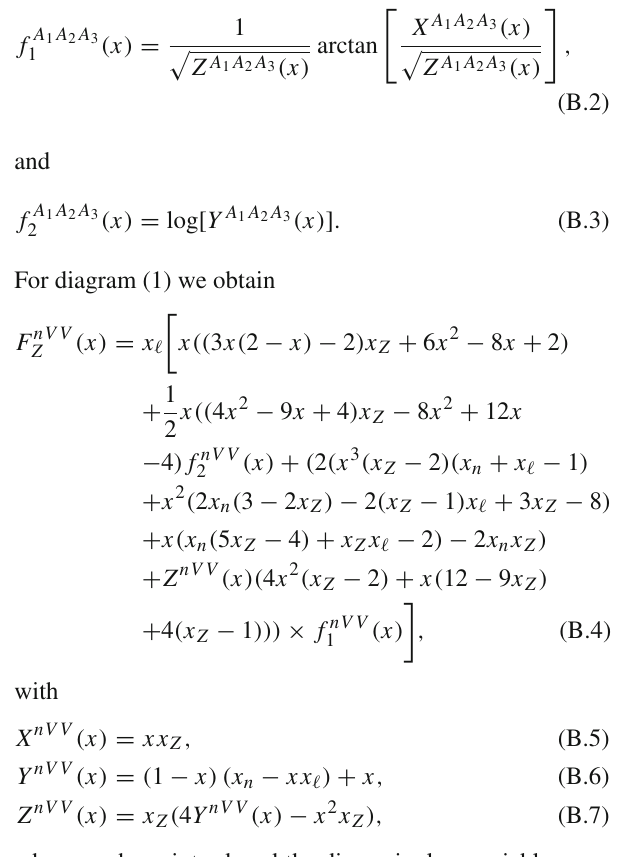
Table 6 Coefficients f A 1 A 2 A 3